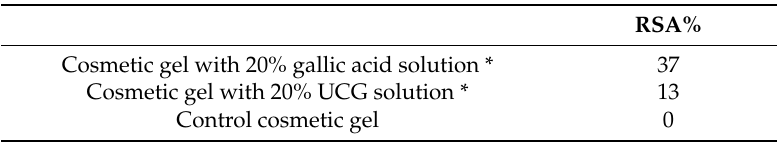
Table 3. DPPH test results of the enriched cosmetic